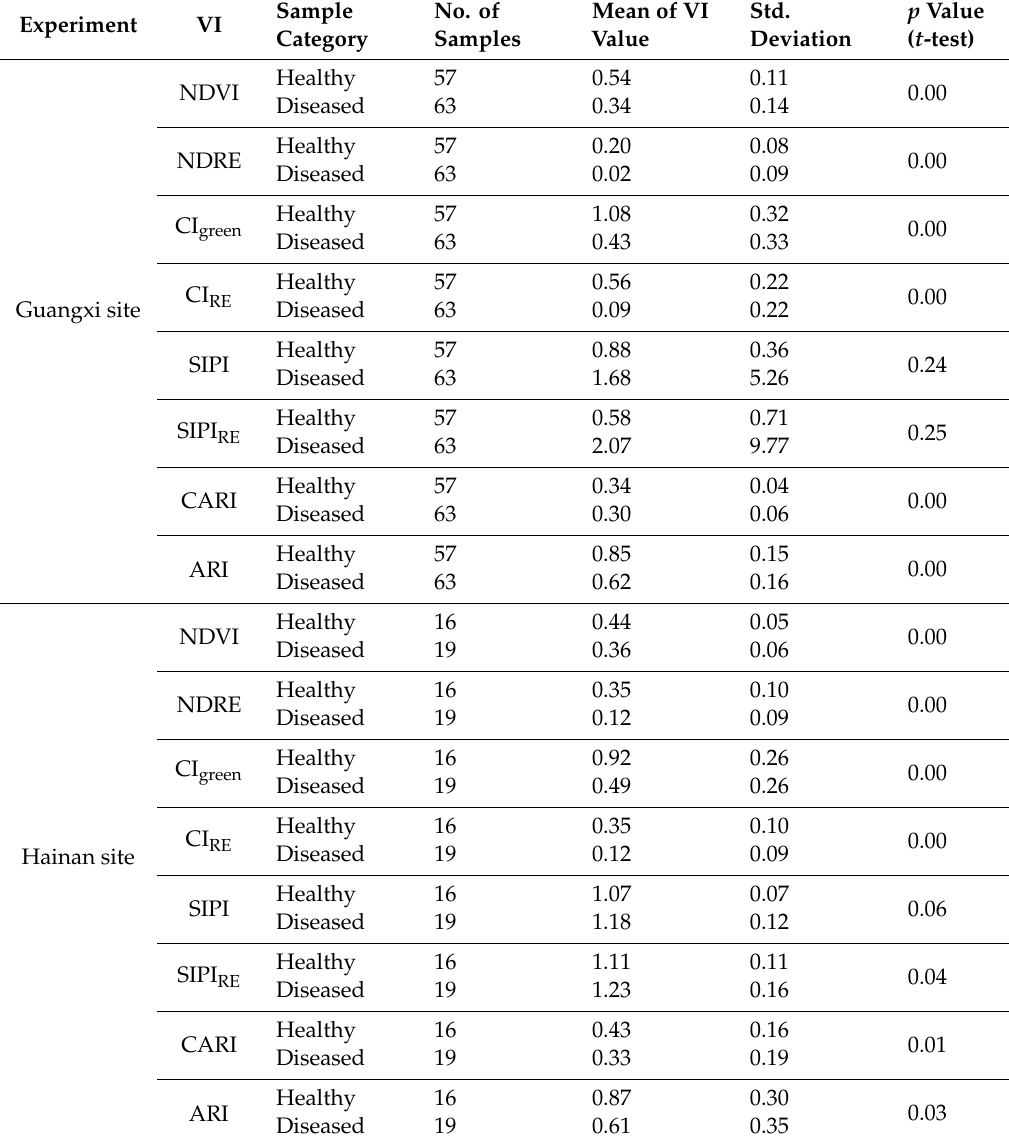
Table 2. Statistical characteristics of VIs values of the healthy and diseased samples.